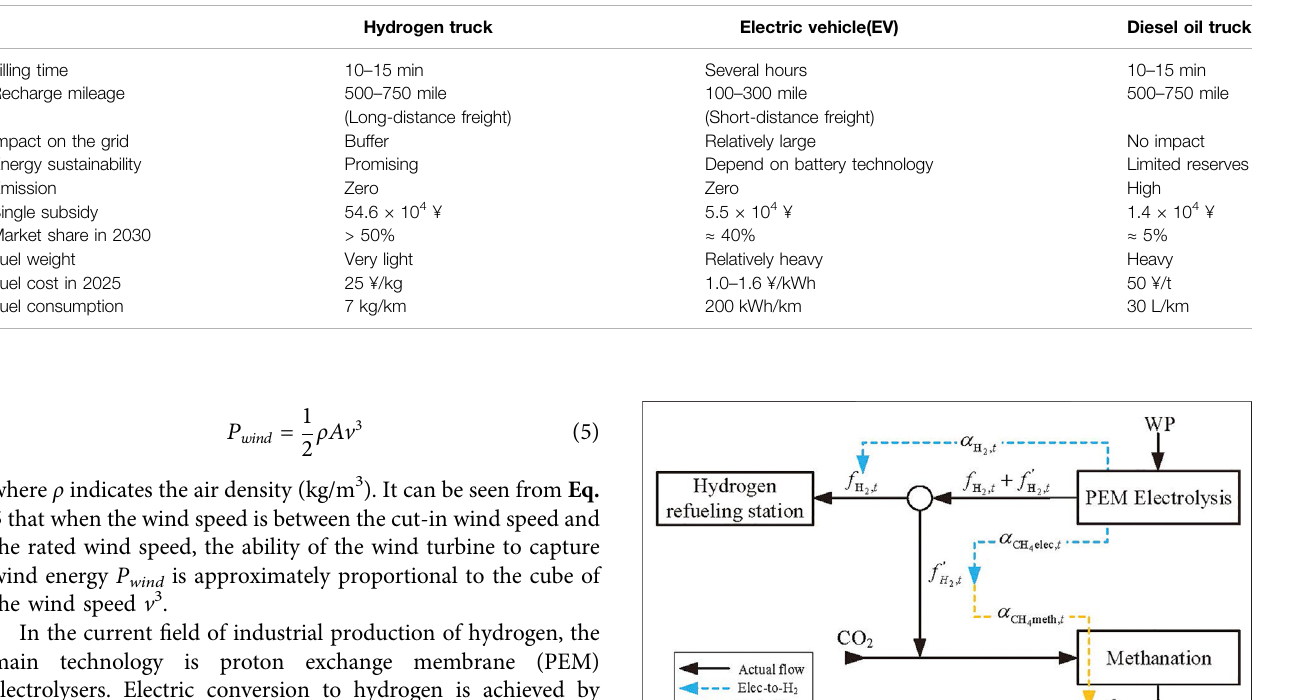
TABLE 1 | Comparison of heavy trucks with different power types.